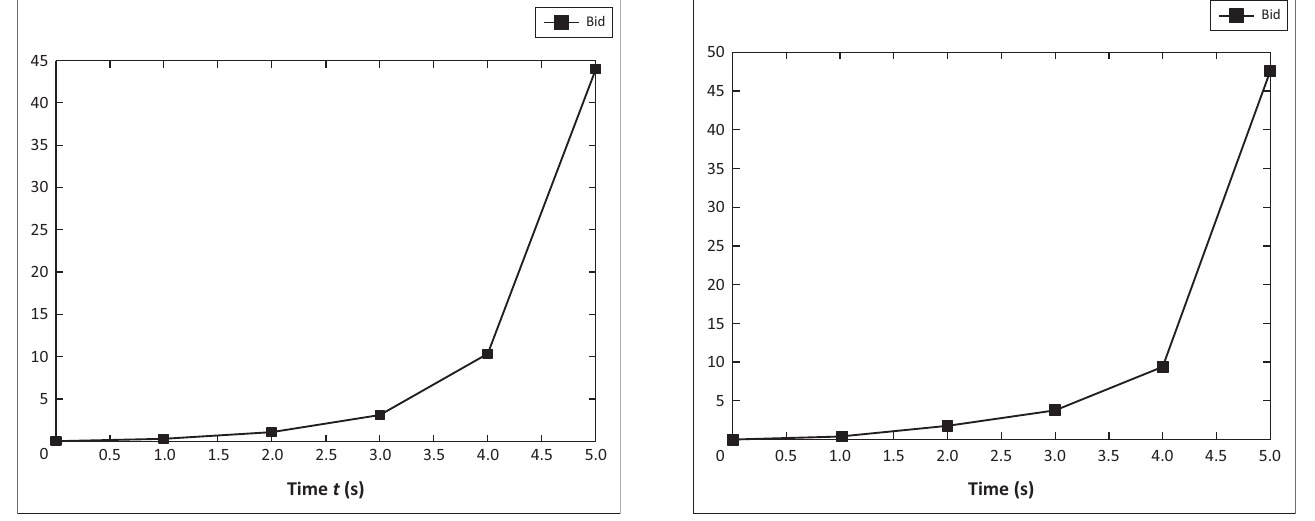
( t ) (asset bidding 1), t ∈ [ t 1